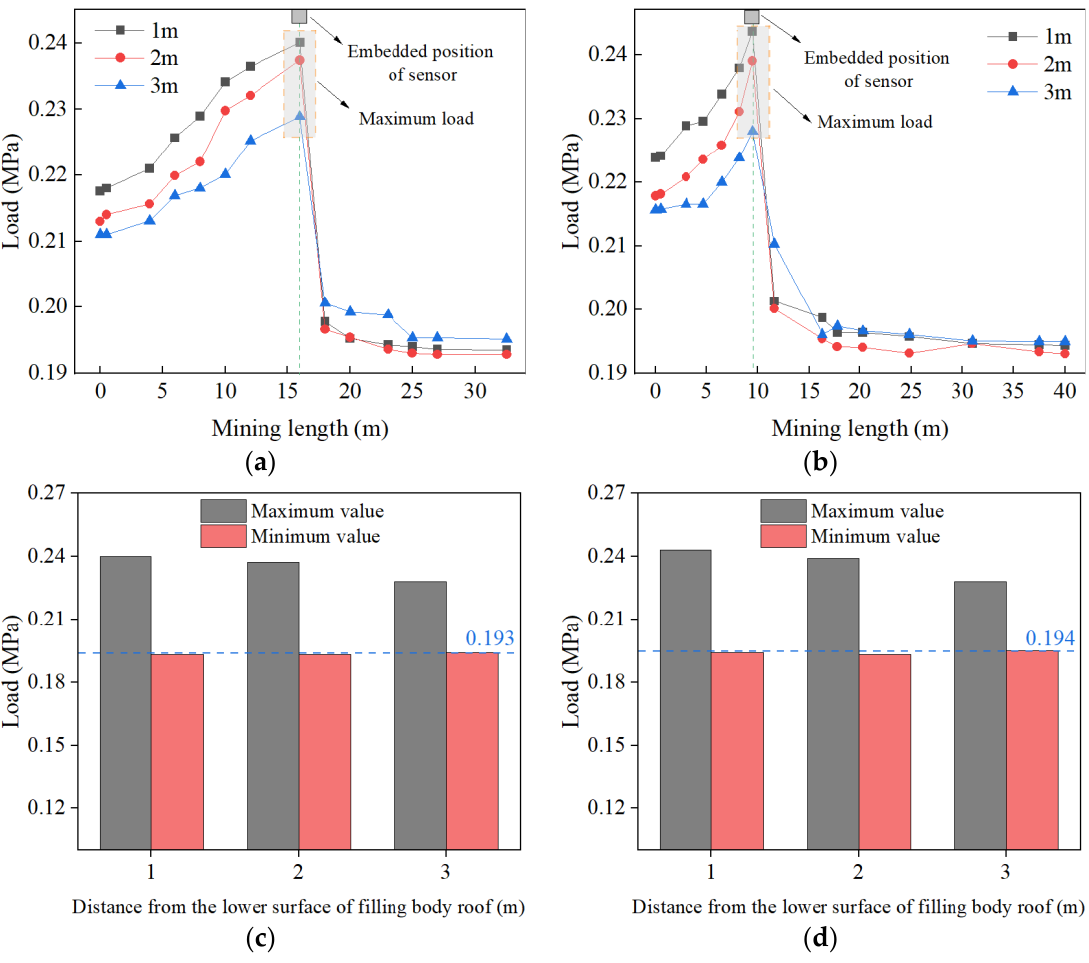
Figure 3. Results of load measurement: ( a ) 48# stope, ( b ) 40# stope, ( c ) maximum and minimum load values of 48# stope, ( d ) maximum and minimum load values of 40# stope.